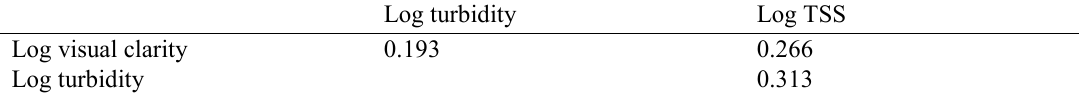
Fig. 2 Example scatterplots of TSS vs visibility for two contrasting sites, one with a close relationship and one with a weak relationship. (Linear regression lines are shown.) Table 2 SE values from regression analysis of log-transformed optical